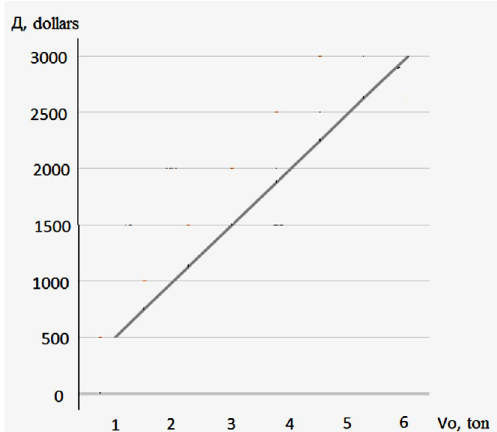
Fig. 6. Dependence of degreasing performance on time Table 1. Comparative data on degreasing with de-limonene and without de-limonene Method degreasing